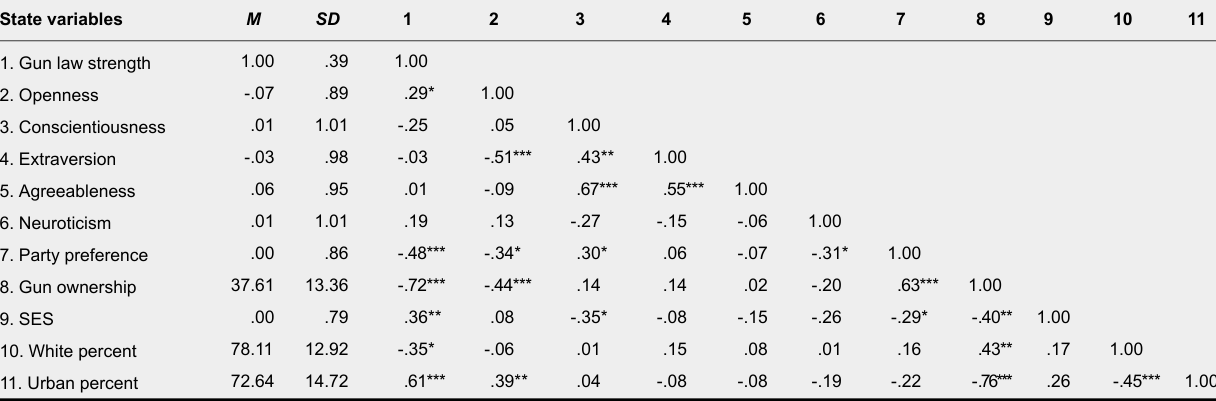
Descriptive Statistics and Pearson Correlations for the Variables in the Study (N = 50)